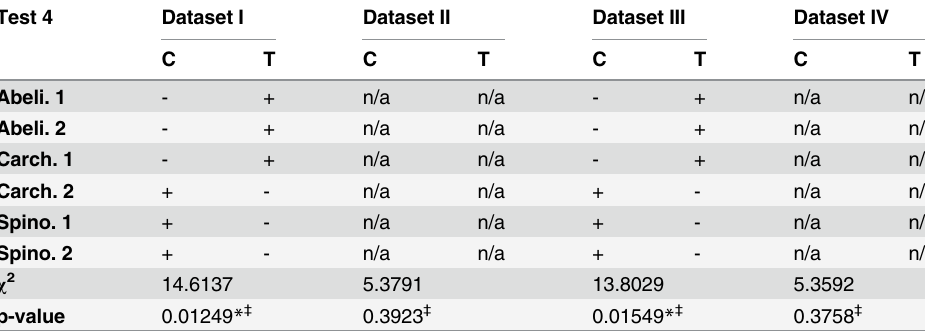
Table 5. Results of Chi-square Test 4 as presented by software R.